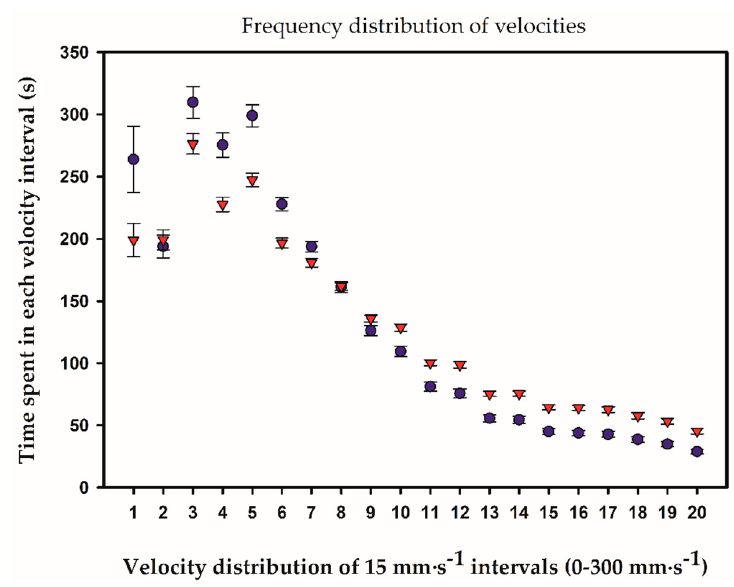
demonstrating the uniform administration of swimming velocity among male zebrafish. Error bars represent SEM.